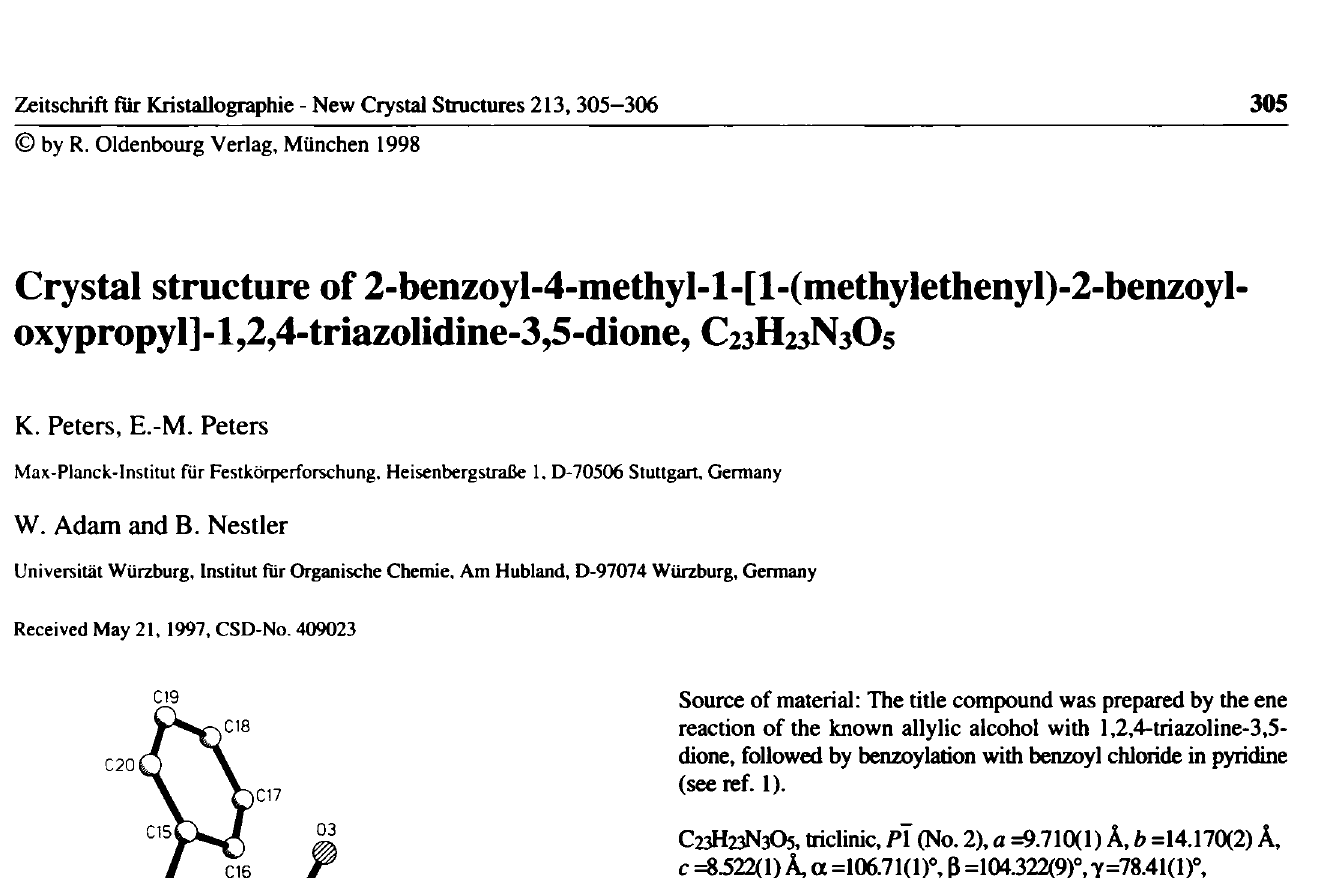
Table 2. Final atomic coordinates and displacement parameters (in